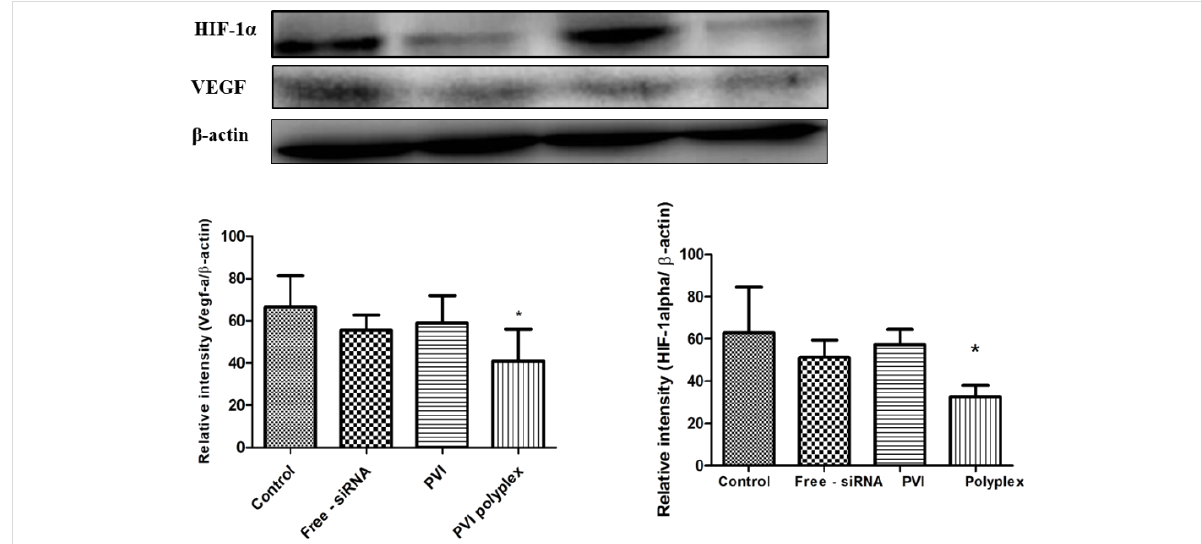
Figure 6: VEGF, HIF-1alpha and β -actin protein expression levels, obtained from Western blot, in A549 cells after different treatments. The expres- sion of VEGF and HIF-1 alpha was normalized to the corresponding expression of β -actin, which was used as house-keeping gene. Data shown as mean ± SD of triplicate independent experiments; * p < 0.05 compared to control.